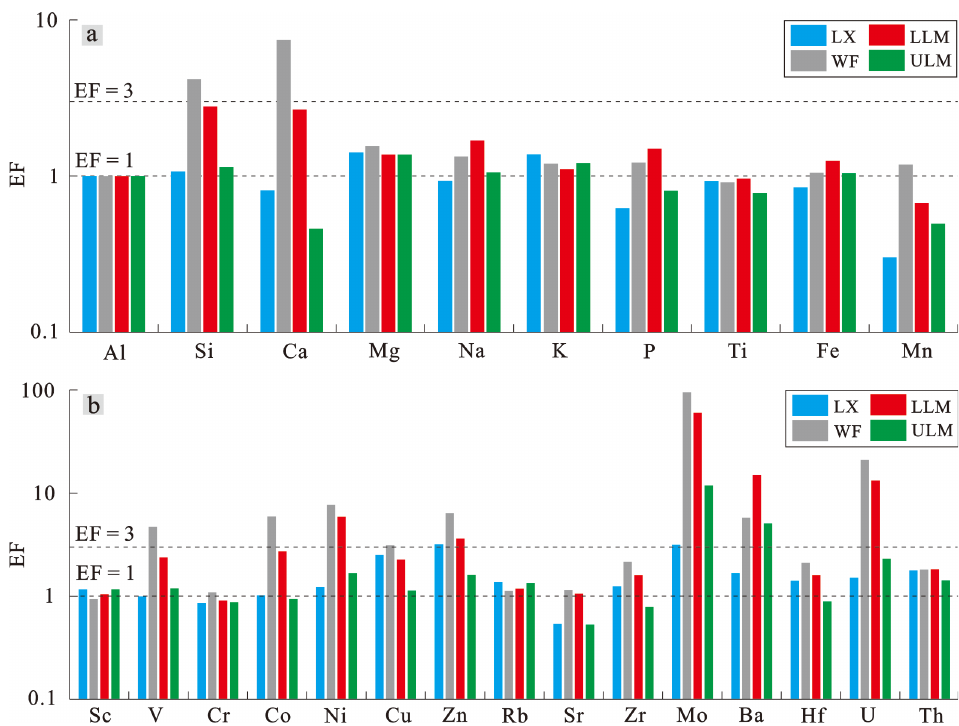
Figure 4. ( a ) Enrichment factors of the major element’s values show that Si, Ca, Na, P, and Fe contents in organic-rich shales are higher than those of organic-lean shales, with moderate to apparent enrichment contents compared to those of PAAS. ( b ) Enrichment factors of the trace elements show that V, Co, Ni, Cu, Zn, Mo, Ba, and U contents in organic-rich shales are higher than those of organic- lean shales, with moderate to apparent enrichment relative to those of PAAS. The dotted line with EF = 1 highlights enrichment or depletion, and the dotted line with EF = 3 highlights apparent or moderate enrichment.